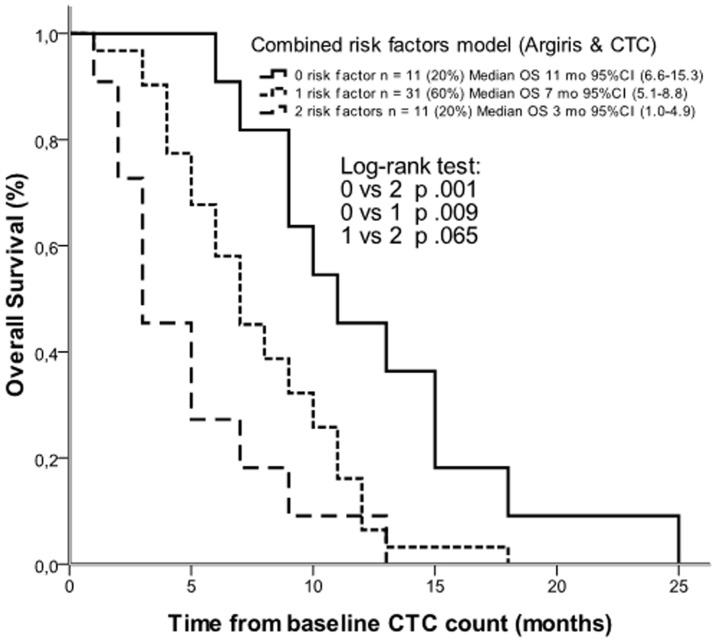
Kaplan-Meier estimates of overall survival according to a combined risk factors model with Argiris factors and CTCs.Continuous line indicates absence of both risk factors; small dotted line indicates the presence of only one of the two risk factors; large dotted line indicates the presence of both risk factors.